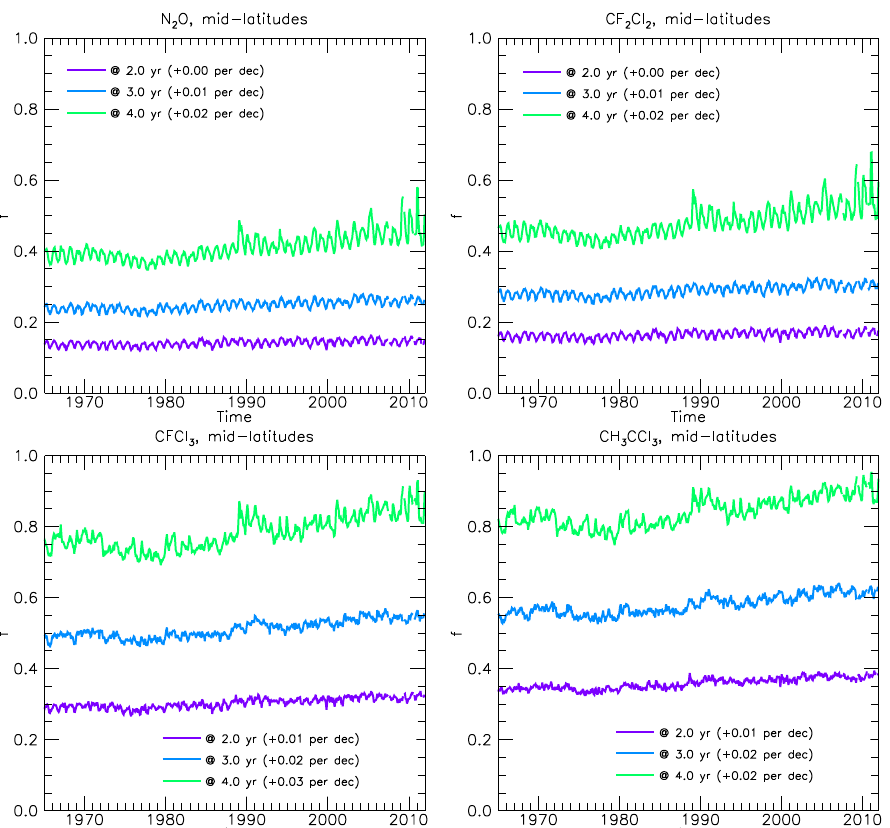
Figure 2. FRF calculated from the idealized tracers (without tropospheric trends) of the EMAC model in the mid-latitudes between 32 and 51 ◦ N. The FRF is calculated on the 2- (purple), 3- (blue) and 4-year (green) age isosurfaces. The absolute change in FRF per decade is noted in